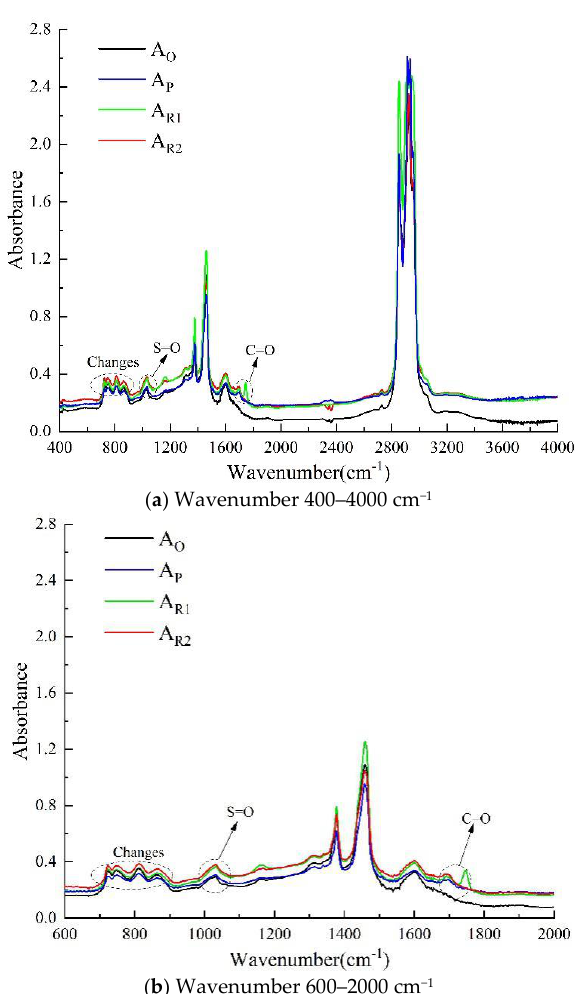
Figure 11. FTIR analysis result of each asphalt binder ( a ) Wavenumber 400–4000 cm − 1 ; ( b ) Wavenumber 600–2000 cm − 1 .